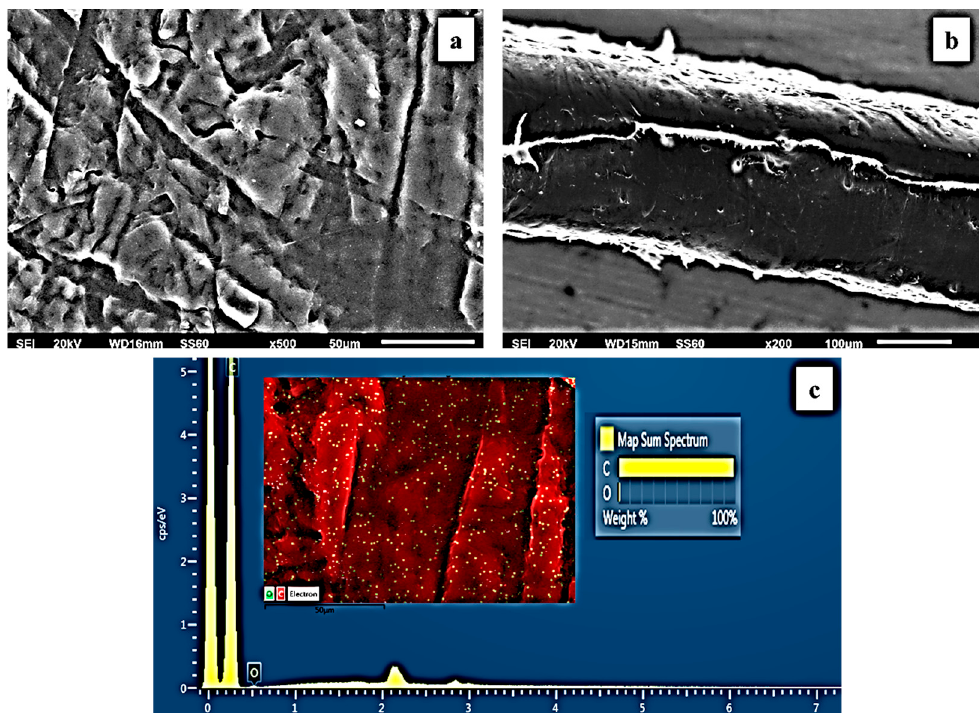
Figure 4. ( a ) SEM images of surface and ( b ) cross-section for the pure LDPE film. ( c ) Energy- dispersive spectrometer (EDS) spectra, relative elemental analysis, and mapping of the surface from the SEM image at ×1000 magnification.